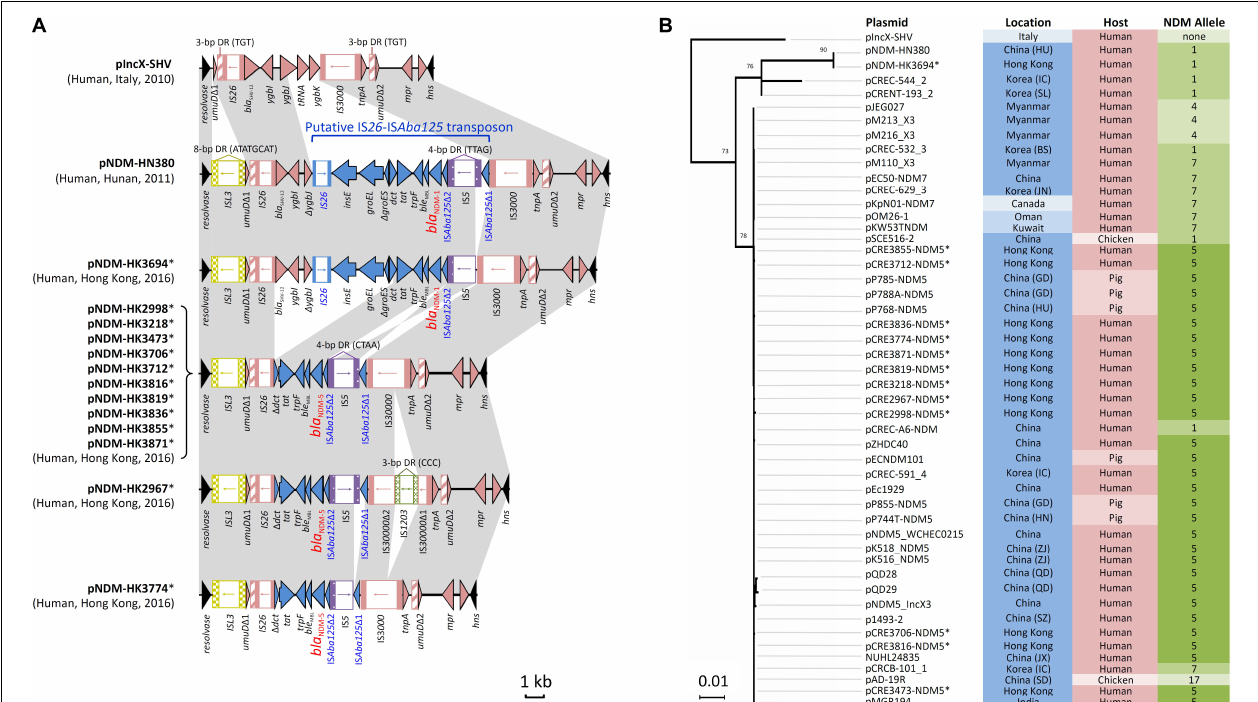
FIGURE 1 | Analysis of IncX3 plasmid sequences in this study. (A) Comparison of genetic load regions in 13 plasmids harboring bla NDM with two reference plasmids (pIncX-SHV and pNDM-HN380). (B) Phylogenetic analysis of 49 IncX3 plasmids using the Maximum Likelihood method based on the Tamura-Nei model. These included two reference plasmids, 13 plasmids in this study and 34 plasmids identified in GenBank (last accessed 16 May, 2018). Branches were drawn to scale, with lengths measured in the number of substitutions per site. Plasmids sequenced in the present study are marked with an asterisk. Each plasmid was labeled and color-coded by the geographical origin (blue intensity: high, Asia; moderate, Middle East; low, Europe and North America), host source (pink intensity: high, human; low, animals), and NDM allele (green intensity: high, allele 5; moderate, alleles 1 and 7; low, alleles 4 and 17).